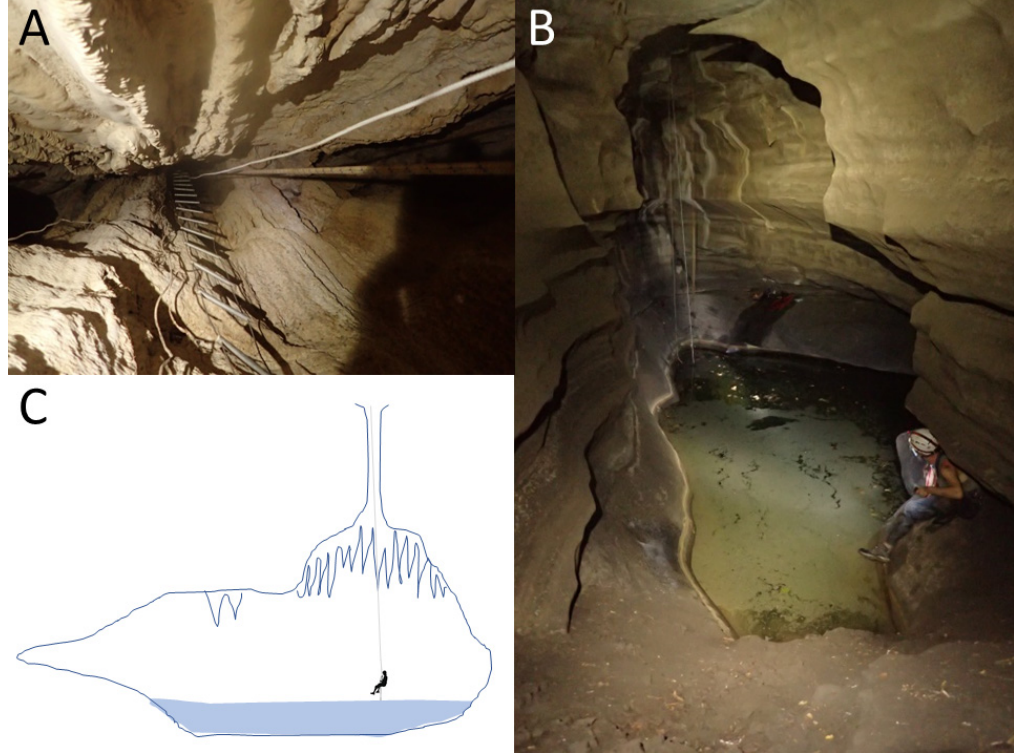
Figure 4. Sótano del Toro #2. ( A ); looking up to the narrow portion of the entrance pit. ( B ); Entrance lake. ( C ); Profile drawing of the entrance pit and lake.